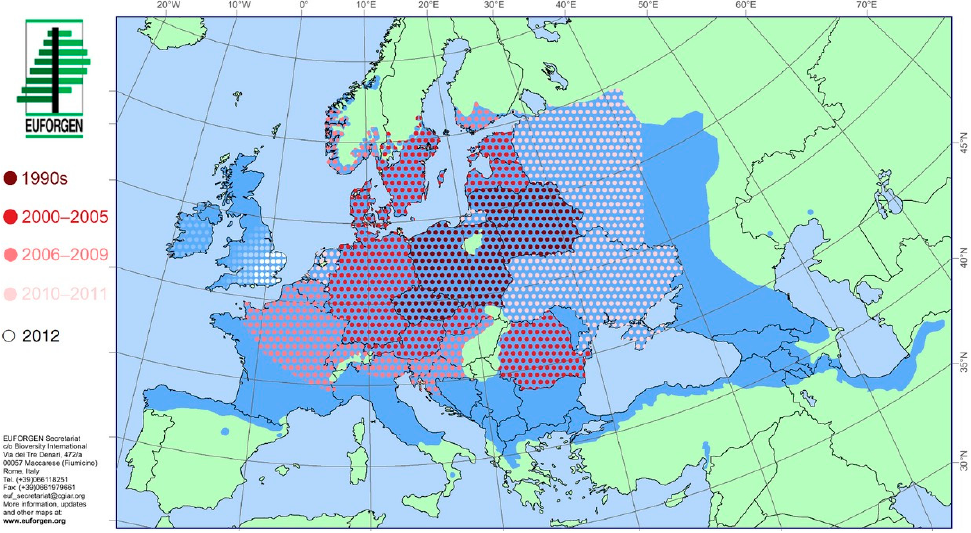
Figure 1. Distribution map of common ash (Fraxinus excelsior) (source: [14], reprinted with permission from Ref. [14]. Copyright 2023, John Wiley and Sons).